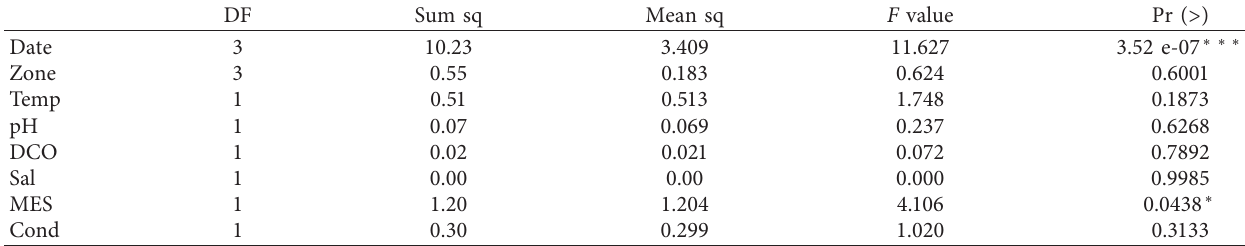
Table 4: Analysis of variances between the parameters of Lake Nokou´e water.